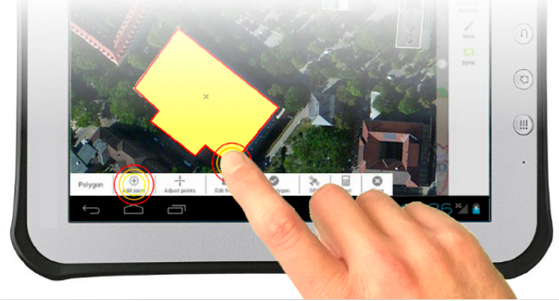
Figure 4. Main UI of GeoTechMobile.